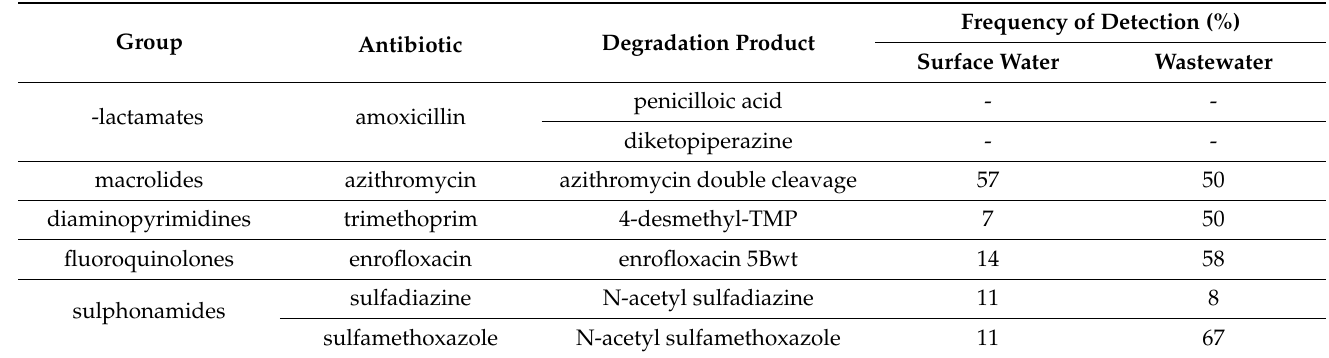
Table 6. Frequency of detection of antibiotic degradation products in surface and